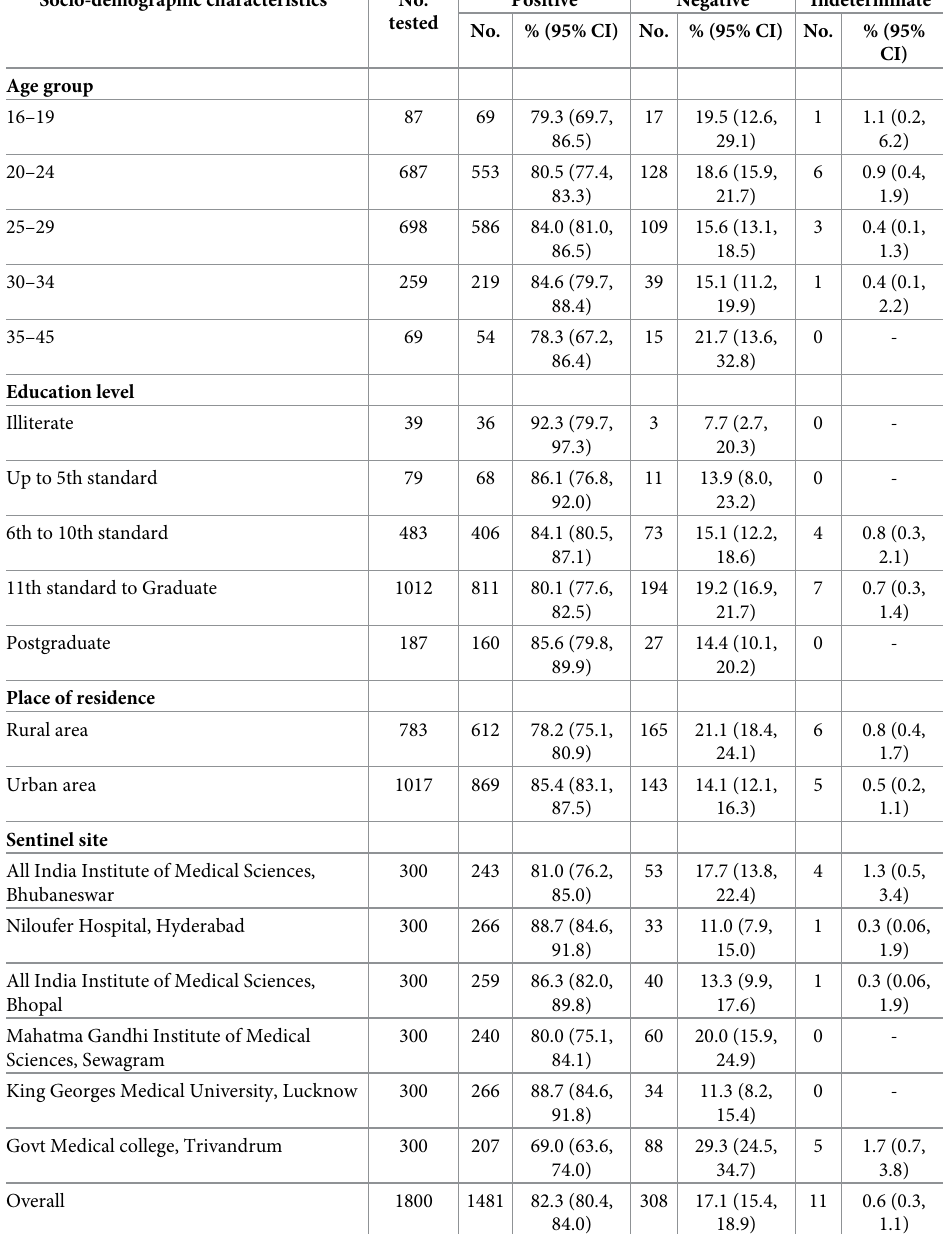
Table 1. Seroprevalence of rubella among pregnant women from six surveillance sites, by selected socio-demo- graphic characteristics, India, 2019–20. Socio-demographic